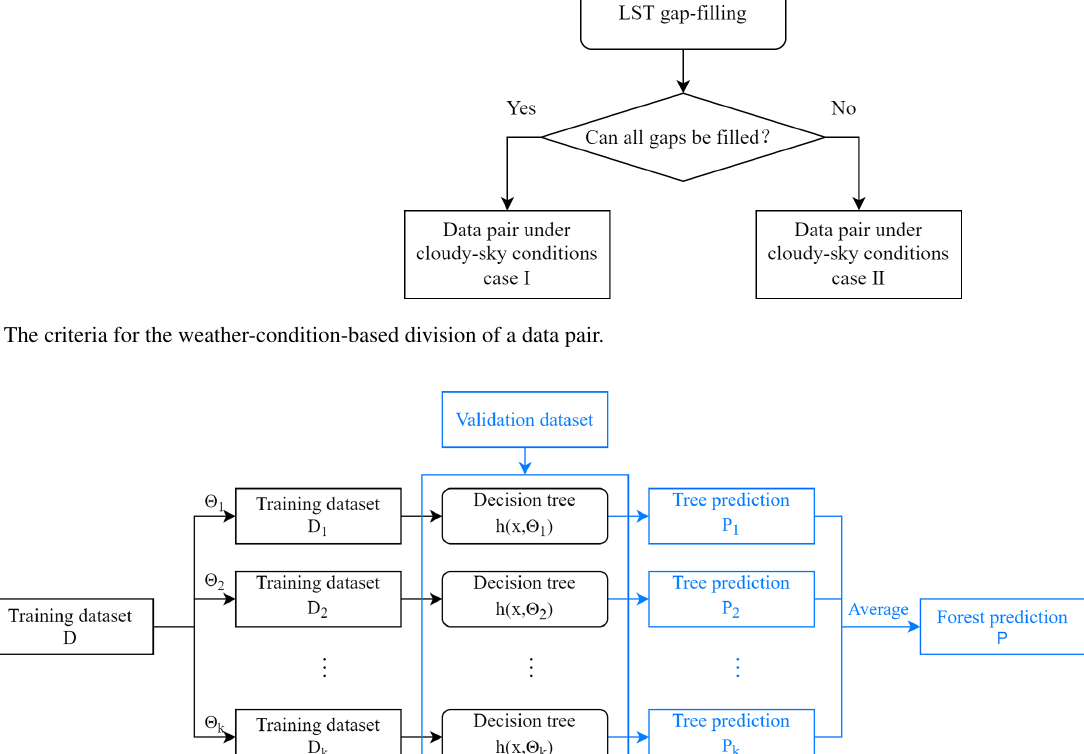
be seen from the results that with the change in model pa- rameters, the three models showed similar variation